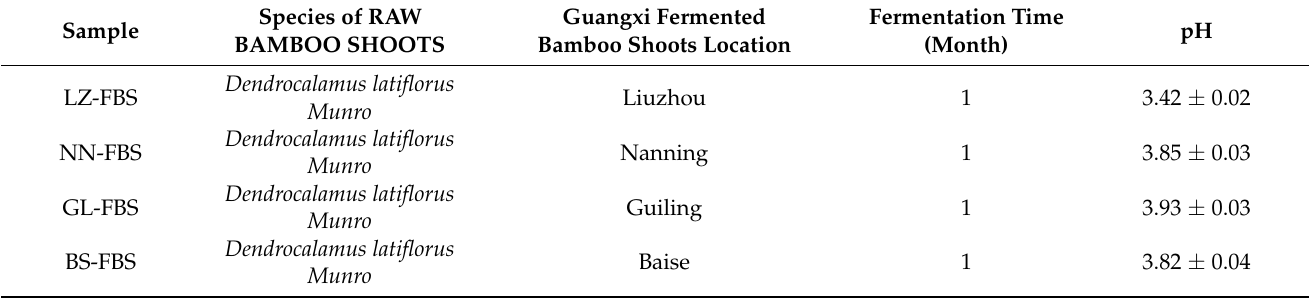
Table A1. Main characteristics of analyzed Guangxi fermented bamboo shoots